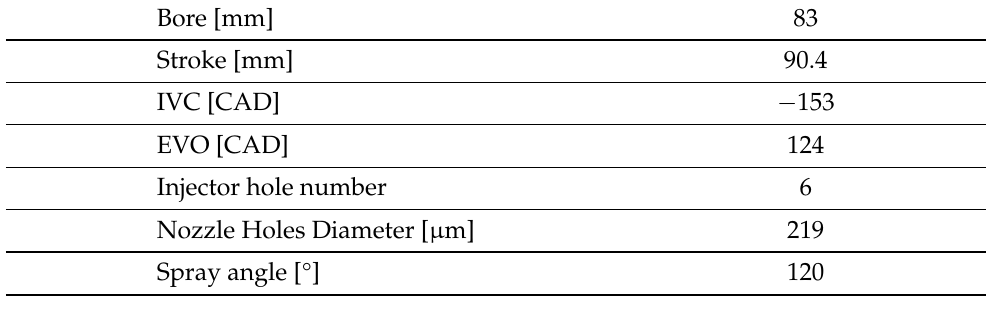
Table 1. Test bench engine specifications. Reference crank angle (0 CAD) is Top Dead Center with closed valves.